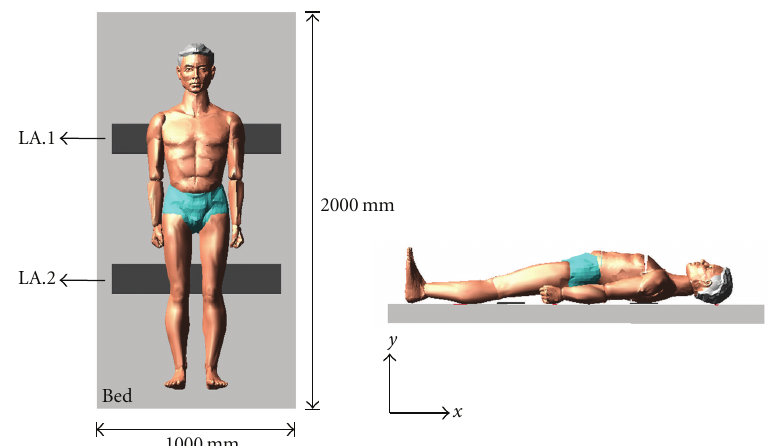
Figure 8: Finding the static equilibrium and initial location of the lifting arms.